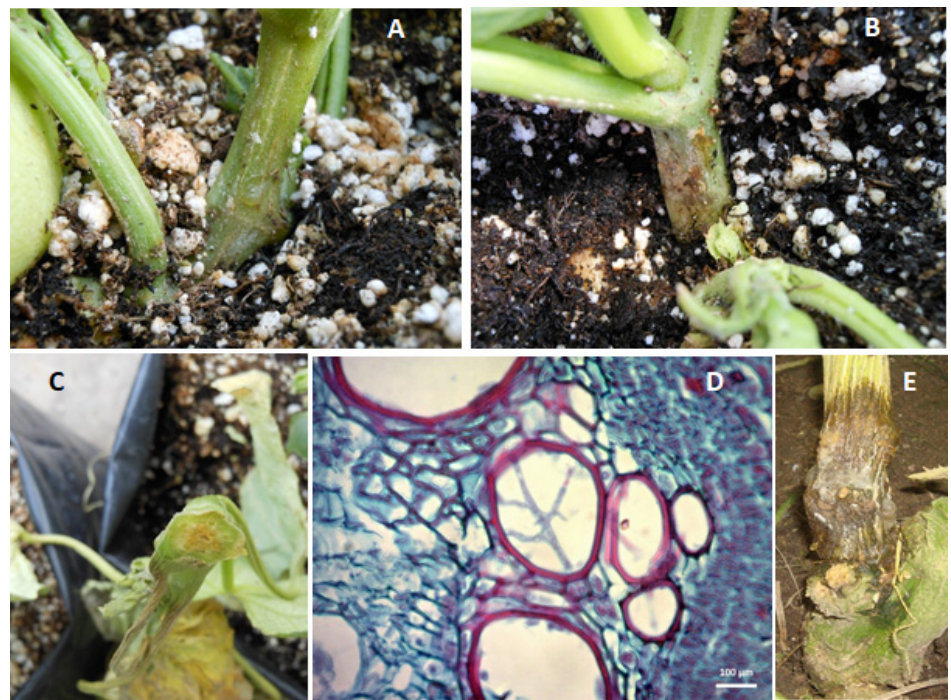
Figure 3. Sequence of damage in the basal vine (vital node) of S. edule var. virens levis Costa Rica Type. ( A – C ) 22 days after inoculation with P. capsici . ( D )Transversal histological section of the stem, with coenocytic mycelial hyphae of P. capsici in the vascular bundle 30 days after inoculation. ( E ) Total necrosis of the adult plant basal guide taken in the field.